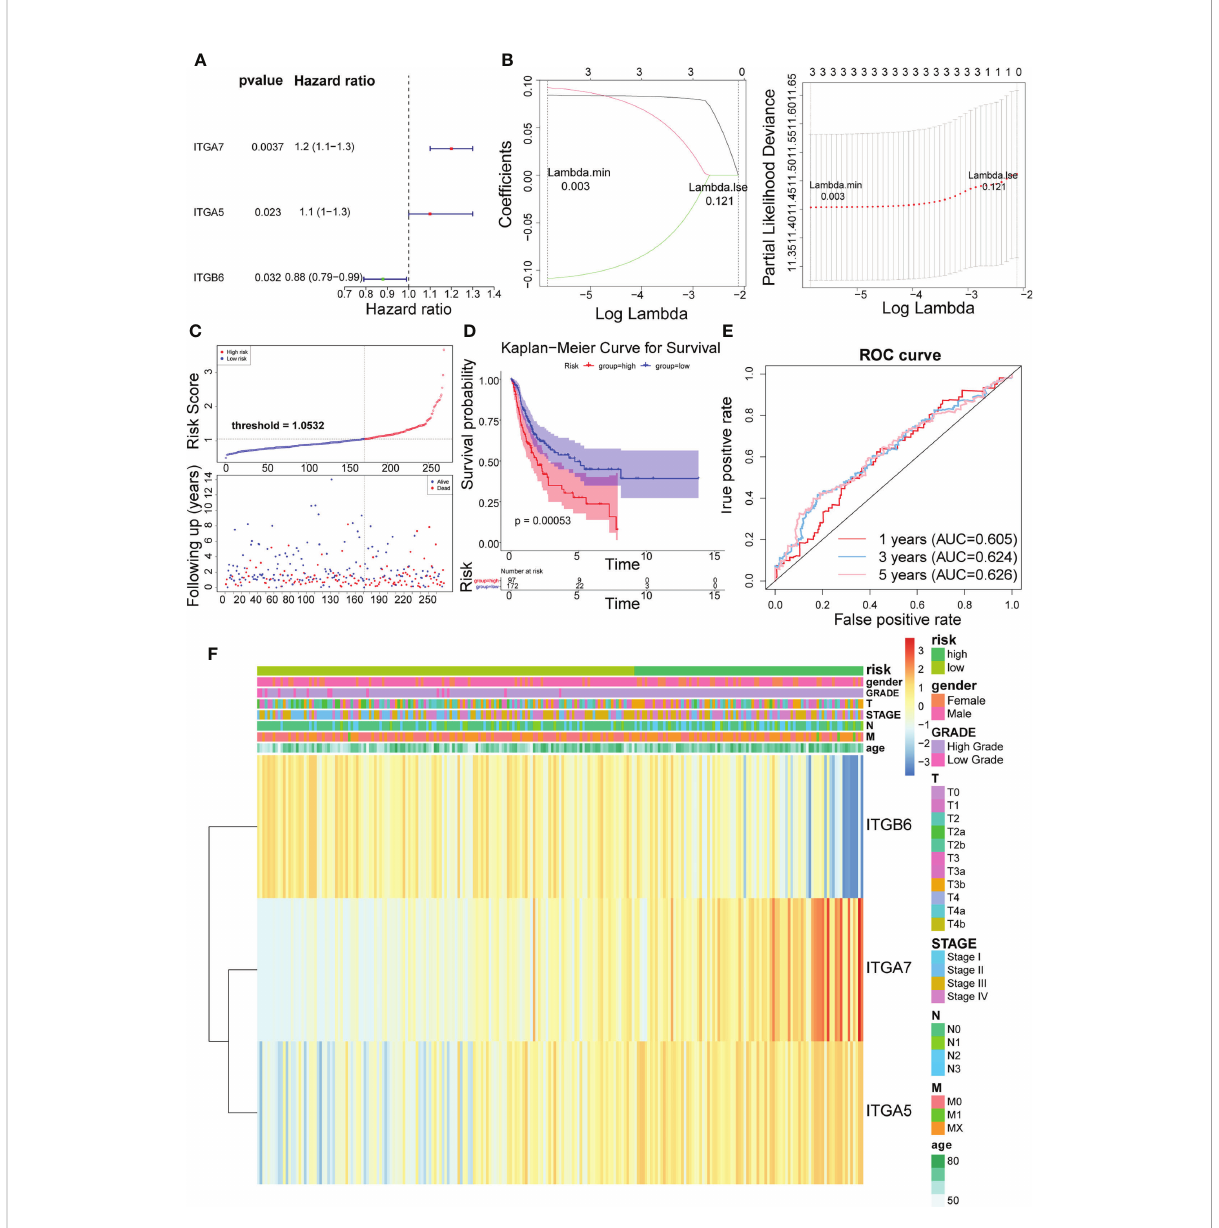
FIGURE 2 Identi fi cation of 3 risk characteristics associated with ITGs in the training set from TCGA cohort. (A) Three condidate model genes were screened by univariate Cox analysis. (B) Three risk characteristics associated with ITGs were identi fi ed by LASSO algorithm. (C) Risk score of the three risk characteristics. (D) Kaplan-Meier curve of the three risk characteristics. (E) ROC curve of the three risk characteristics. (F) The heatmap of the three risk characterastics in high- and low-risk groups, the distribution of clinicopathological features was compared between the low- and high-risk